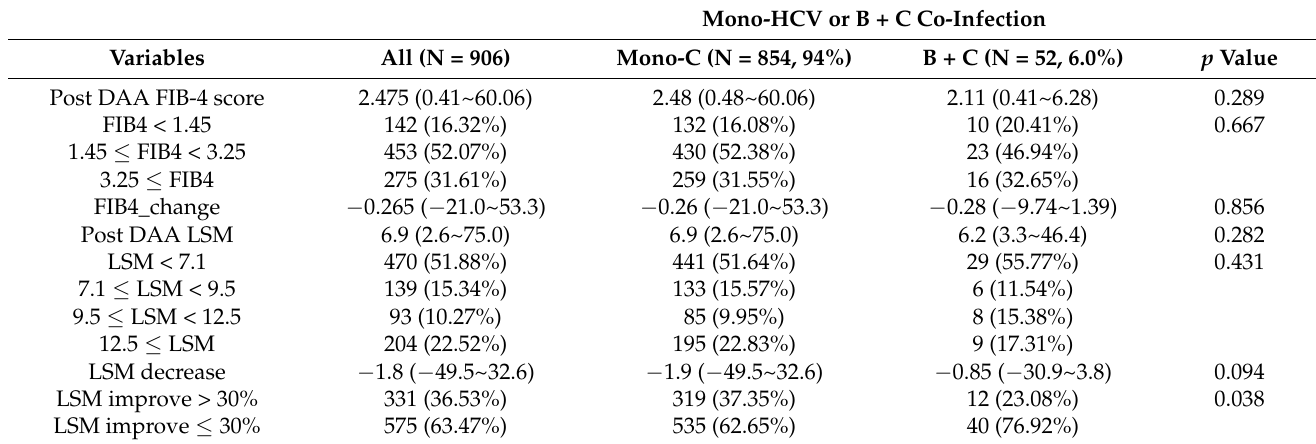
Table 1. Post-treatment demographic comparison between patients with dual infection and mono-HCV. Mono-HCV or B + C Co-Infection